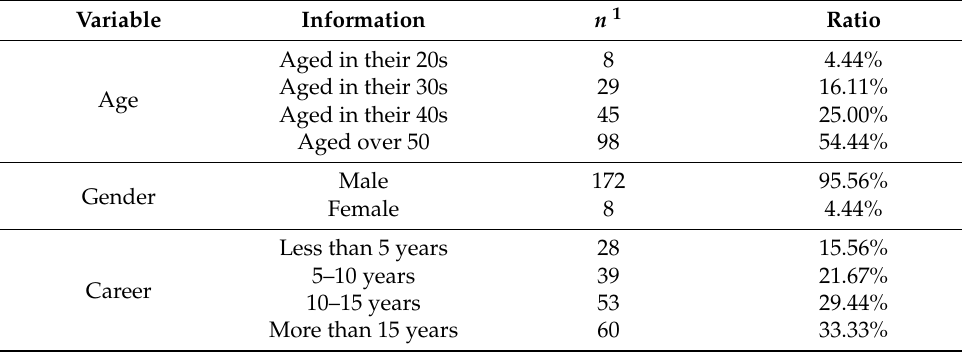
Table 1. Information of workers who participated in